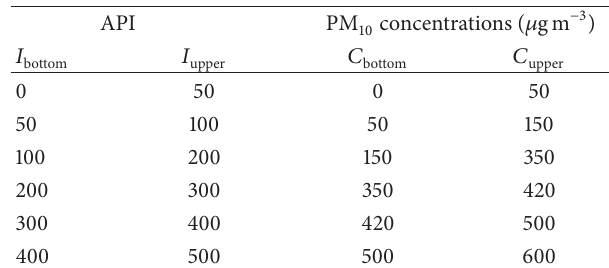
Table 1: The bottom and upper limit of API values and correspond- ing PM 10